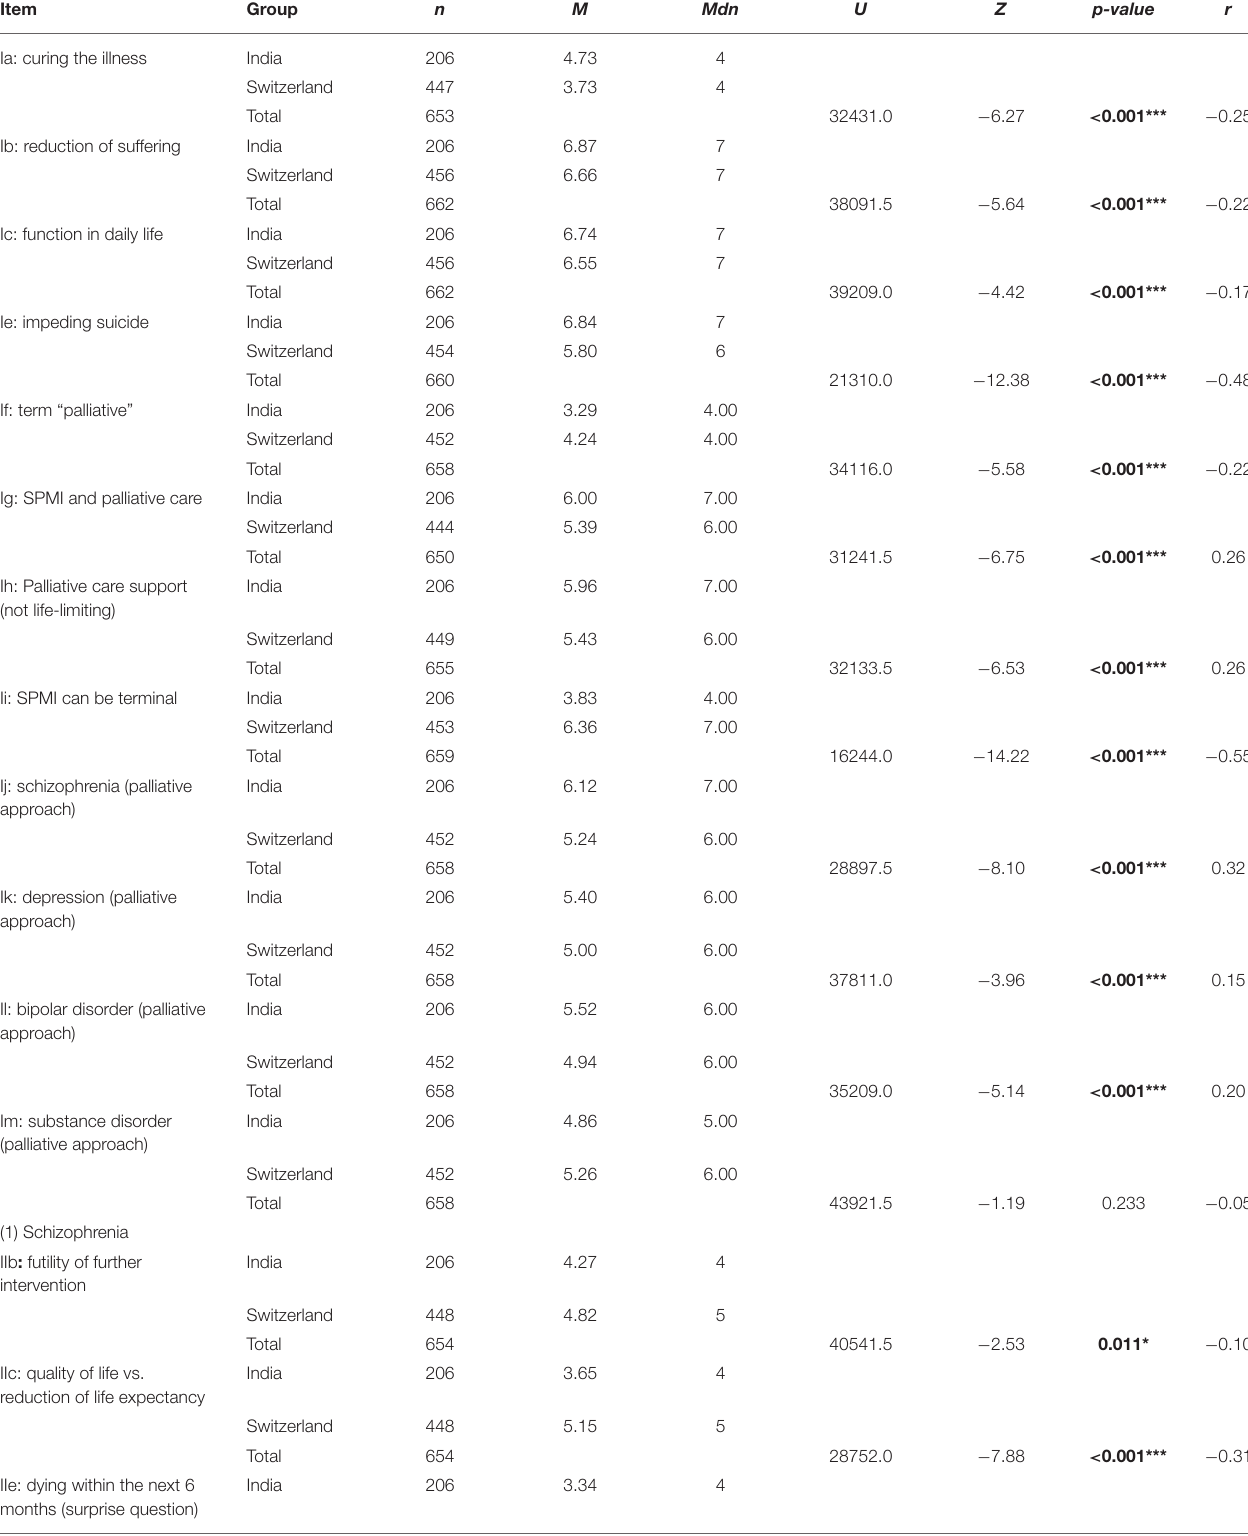
TABLE 2 | Comparison of India and Switzerland. Item Group n M Mdn